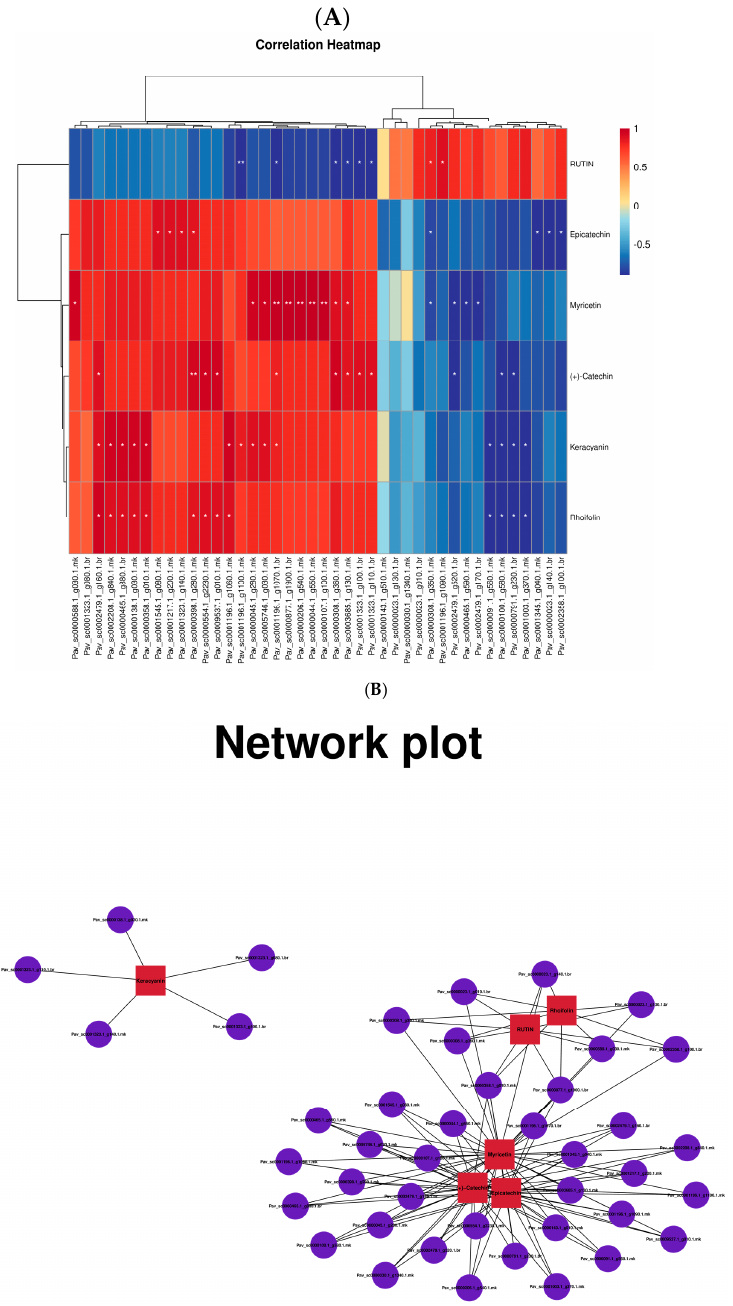
Figure 5. Principal component analysis (PCA) analysis of RNA − seq between the cultivars. Co-expression analysis of structural genes of anthocyanin, flavonoid, flavone, and flavanol bio-